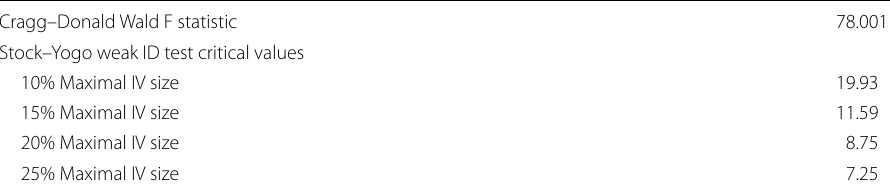
Table 7 Weak instrument test results